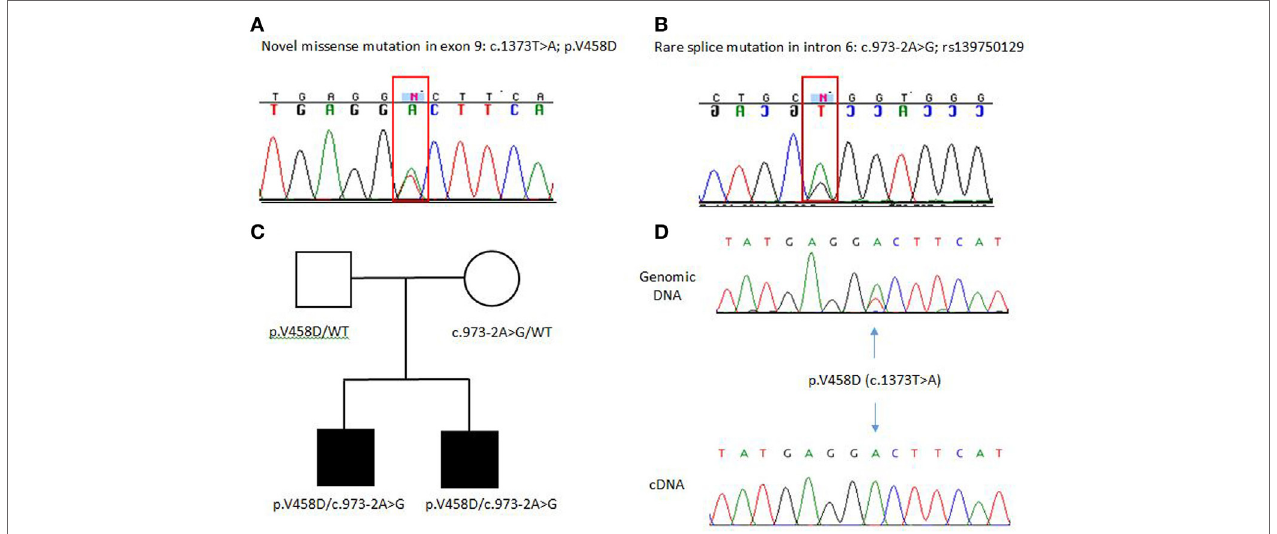
FIGURe 1 | (a,B) Electropherograms of ADA2 pathogenic mutations identified in the family. (C) Family pedigree, both unaffected parents are carriers of these mutations. WT indicated wild-type or non-mutated ADA2 allele. (D) cDNA sequencing shows that the p.V458D mutation appears heterozygous at the genomic DNA and as a homozygous mutant allele when transcribed in cDNA indicating null expression of the second allele due to the c.973-2A > G mutation.